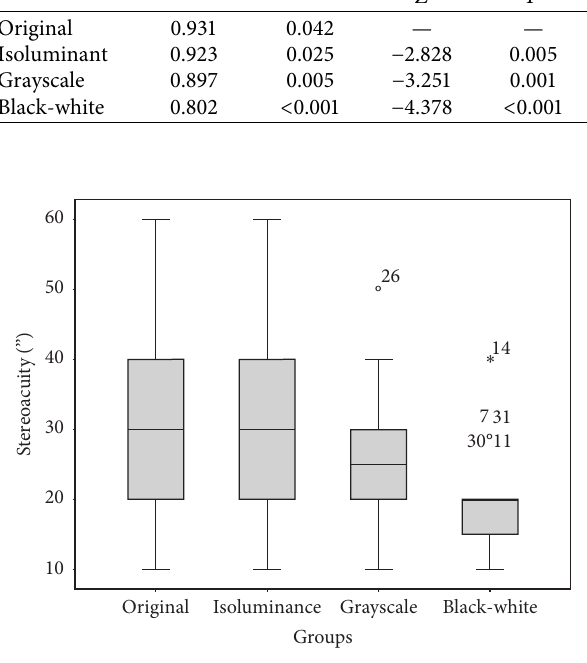
Figure 4: Boxplot of the stereoacuity of the four groups. The line perpendicular to the whisker below the box represents the mini- mum value; the lower edge of the box represents the first quartile; the thick solid line is the median; the upper edge of the box represents the third quartile; the line perpendicular to the whisker above the box represents the maximum value. Circles and star represent